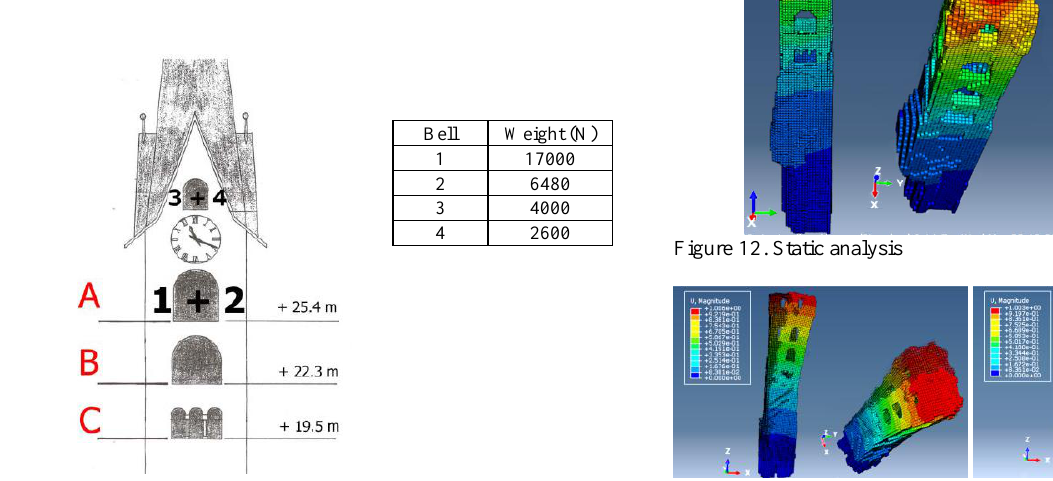
Figure 11. Position and weights (in Newton) of the bells (Cantieni et al., 2013)